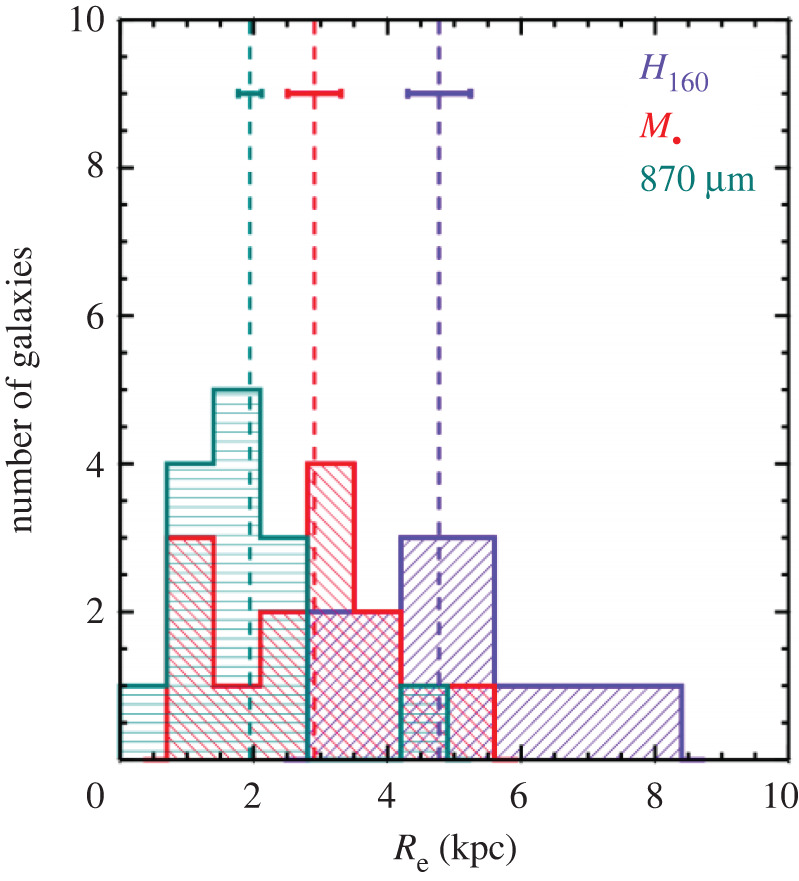
Histograms of the effective radii for the ALMA 870 μm continuum emission, stellar mass profiles, and Hband-light for the SMGs studied by Lang et al. [450]. The stellar mass distributions were inferred from spatial mass-to-light ratio corrections based on rest-frame optical colours. The compact FIR continuum sizes measured for FIR-bright sources compared with their implied stellar mass distributions suggests that these galaxies are experiencing intense periods of morphological transformation and bulge growth. Figure from Lang et al. [450].